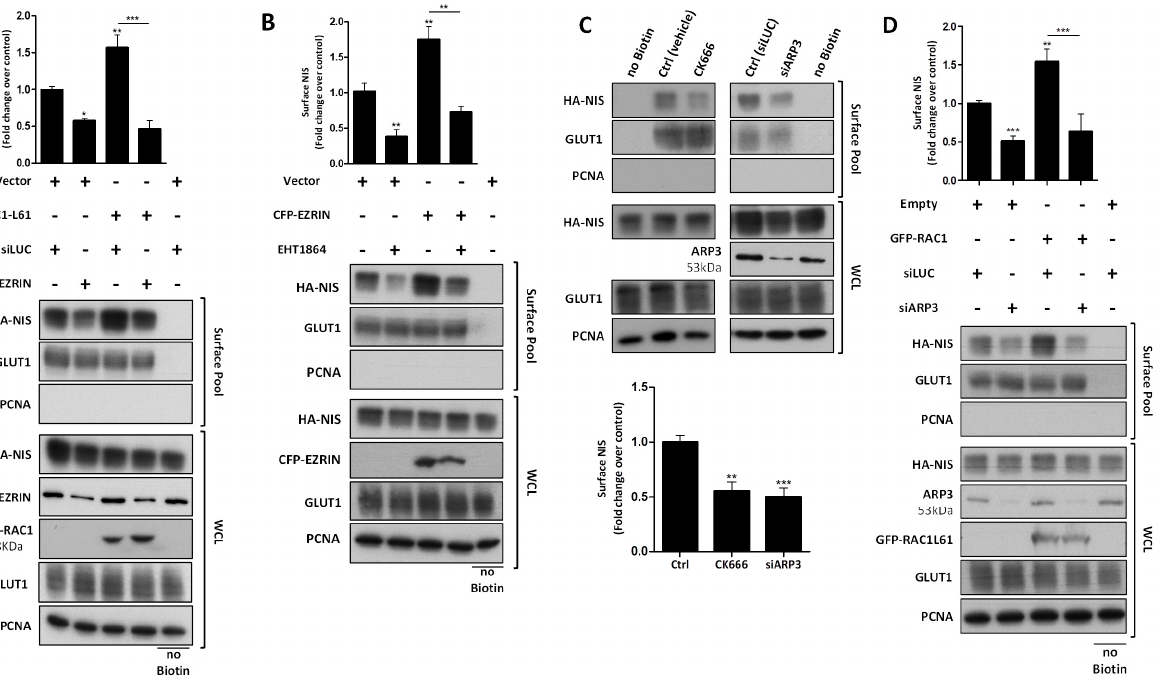
Figure 6. EZRIN and ARP2/3 activity are required downstream of RAC1 to sustain HA-NIS PM residency. HA-NIS-TPC1 cells were transfected with either ( A ) GFP-RAC1-L61 or a siRNA against EZRIN, or both; ( B ) with CFP-EZRIN in the presence or absence of the RAC1 inhibitor EHT1864 (50 µM for 1 h); ( C ) with either mock (siLUC control) or siARP3, and treated or not with the ARP2/3 complex inhibitor CK666 (100 µM for 1 h); or ( D ) with either empty vector (Empty) or GFP-RAC1-L61, and either mock (siLUC control) or the siARP3, as indicated, and analyzed by surface protein biotinylation. Surface fractions and whole-cell lysates (WCL) were then analyzed by WB, as indicated. The ‘no Biotin’ condition corresponds to cells not incubated with biotin, and was used to control the specificity of biotinylated protein pull-downs. PCNA expression served as both the loading (WCL) and intracellular protein contamination control (Surface pool). GLUT-1 served as the positive loading control for the cell-surface protein extracts. The WB bands were quantified by densitometric analysis using ImageJ software. The plotted values correspond to the means ± SEM of at least three independent assays. One-way ANOVA analysis detected the significant differences between the treatments [F = 23.65 and p < 0.001 for ( A ); F = 17.86 and p < 0.001 for ( B ); F = 14.79 and p < 0.001 for ( C ); F = 18.26 and p < 0.001 for ( D )]. Post-hoc Tukey’s tests were used to identify significant variations relative to the control conditions or among the different treatments (the latter are indicated by horizontal lines) (* p ≤ 0.05; ** p ≤ 0.01; *** p ≤ 0.001).